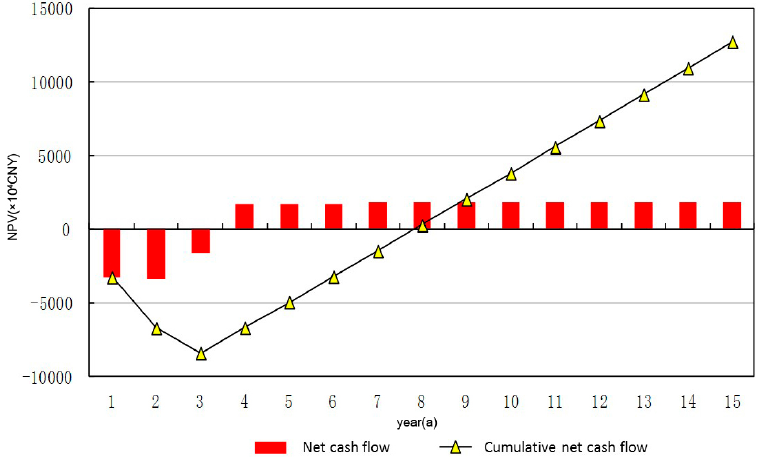
Figure 3. Geothermal project cash flow.